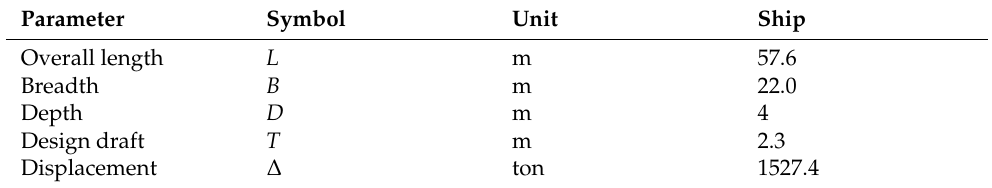
Table 1. Overview of the ship.